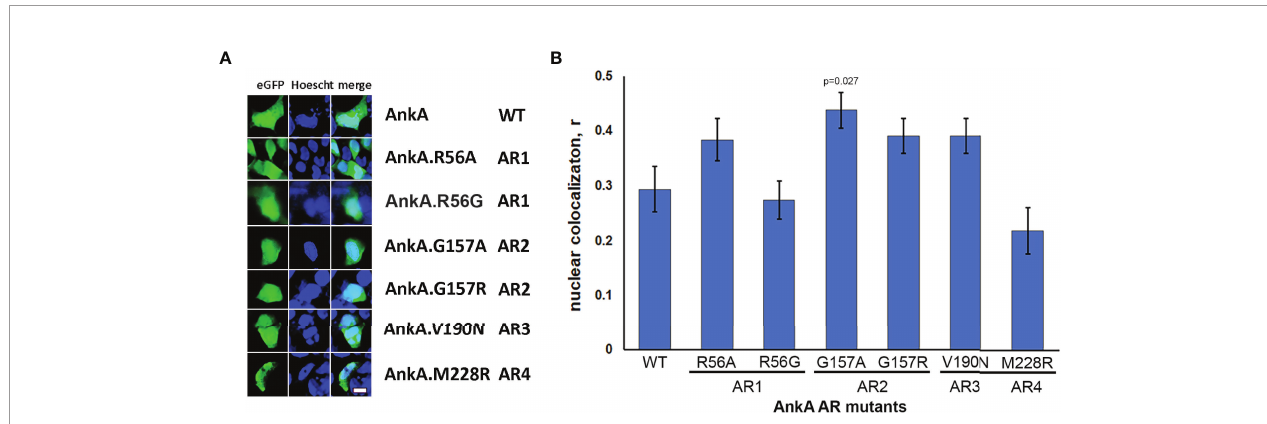
FIGURE 2 | Single mutations of N-terminal ankyrin repeats did not reduce nuclear localization of AnkA. HEK293 cells were transfected with eGFP plasmid constructs of wild-type AnkA or AnkA N-terminal ankyrin repeats 1, 2, 3 and 4 with point mutations, as described in Experimental Procedures. After 48 hours, the cells were fi xed, washed, stained with cell-permeable nuclear label Hoescht33342 (Hoescht) and visualized with fl uorescent microscopy. (A) Representative images of cells transfected with eGFP-AnkA and ankyrin repeat mutants of eGFP-AnkA. (B) Statistical analysis of nuclear colocalization of AnkA mutants with nuclear staining relative to wild type AnkA. Data are mean ± SEM, n=20-40 of randomly selected ROIs (region of interest) containing 120-200 transfected cells. ANOVA post hoc Bonferroni corrected p values <0.05 relative to wild type AnkA are shown. Bar – 20